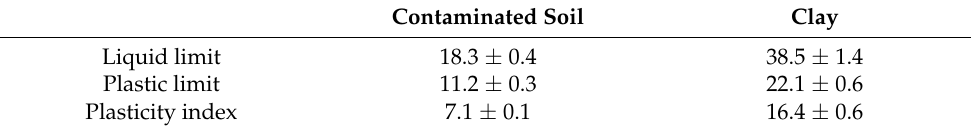
Table 3. Liquid limit, plastic limit and plasticity index of the contaminated soil and clay.